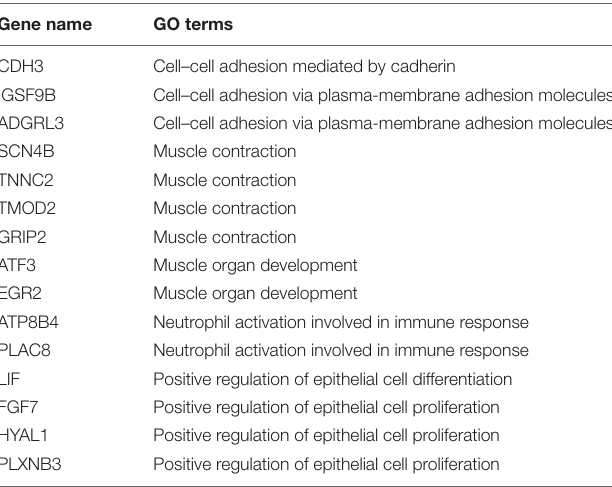
TABLE 2 | The DEGs from high enriched GO terms that are significantly correlated to m 6 A RNA methylation regulators cluster in the myometrium.